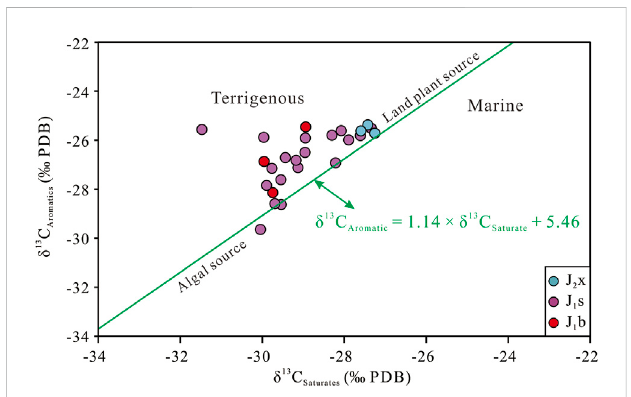
FIGURE 5 Saturate/aromatic hydrocarbon ratios vs asphaltenes + resins concentrations showing the depositional setting, maturity and kerogen type of the Jurassic organic-rich shale in the East Fukang Sag, Junggar Basin,